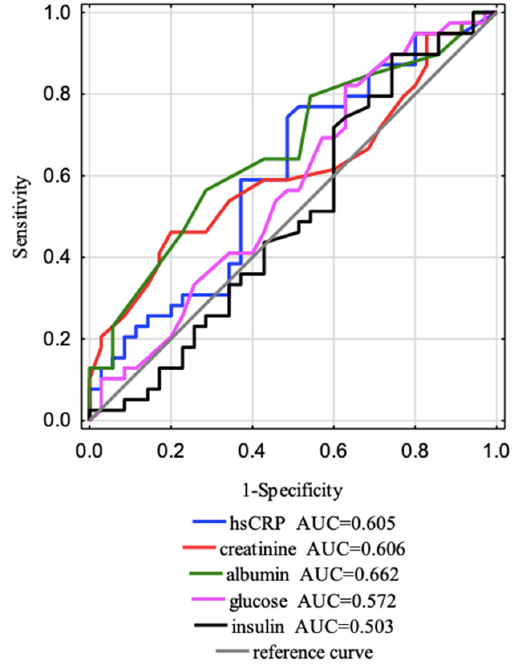
Figure 4. Five ROC curves and AUC values of the clinical parameters studied were designed to distinguish factors that affect vitamin D concentration (cut-off point 18.5 ng/mL).